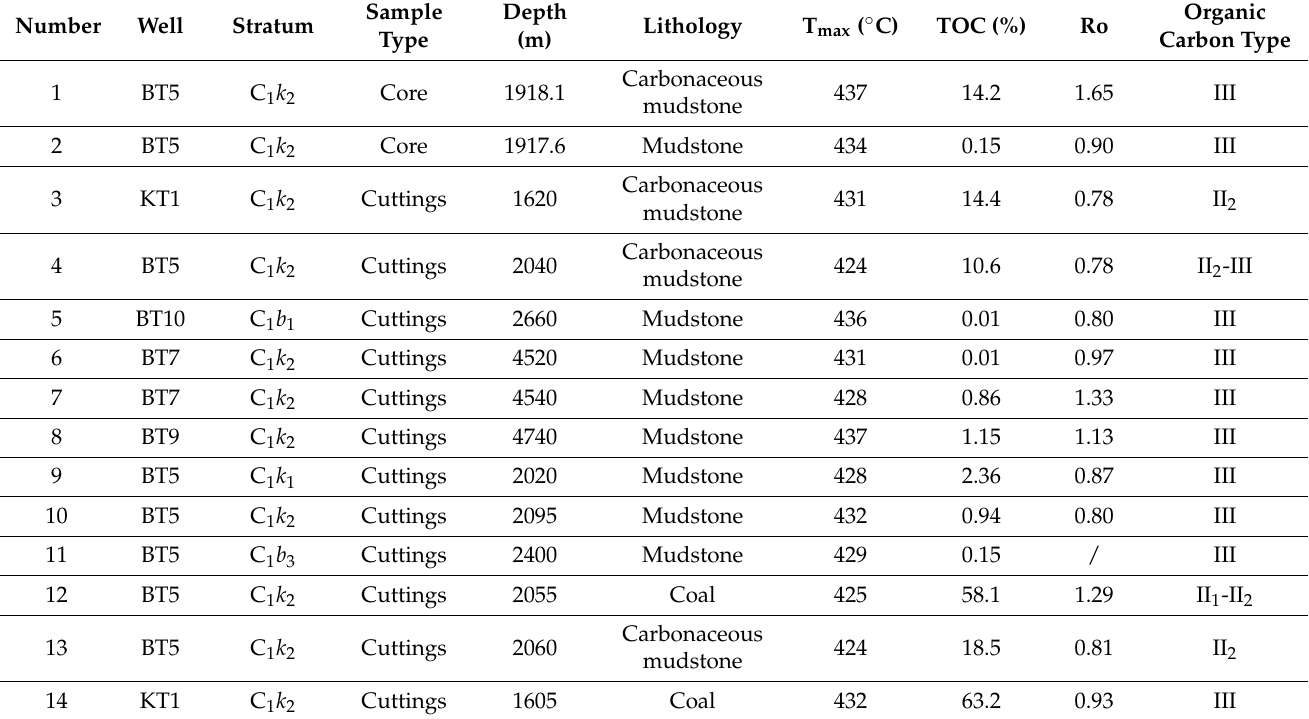
Table 1. TOC, Ro, and organic carbon type of hydrocarbon source rock samples from the Carbonifer- ous Karashayi Formation and Bachu